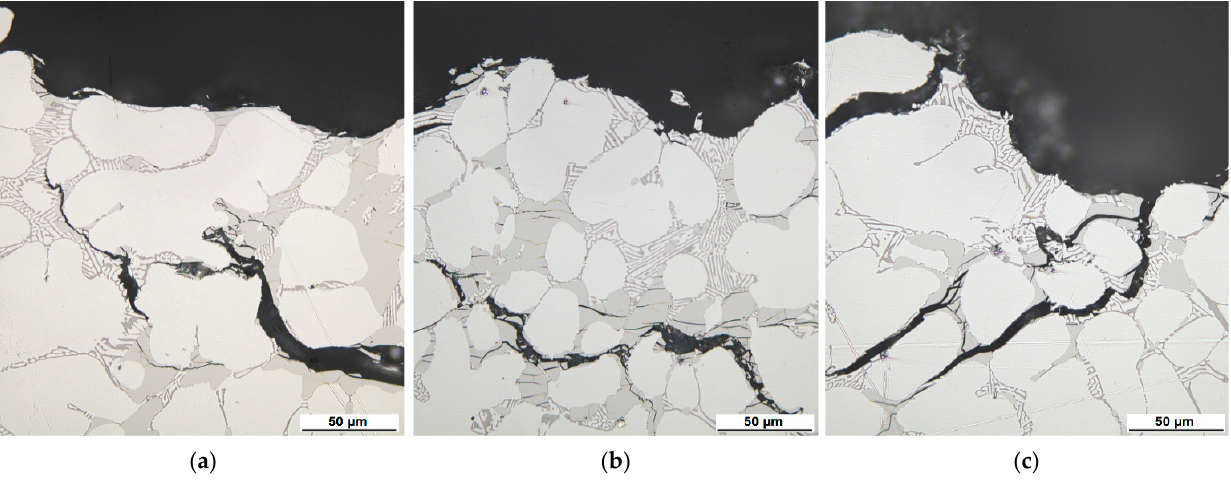
Figure 4. Cross-sectional micrographs of fracture surface after tensile load showing the crack prop- agation of the sub-cracks near the main crack and its interaction with the microstructural features ( a – c ).